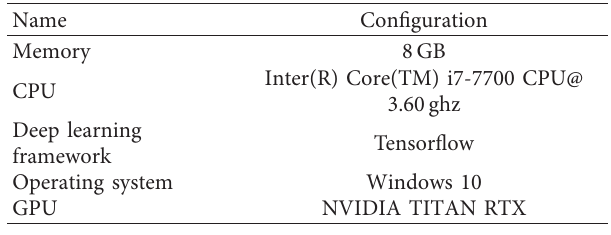
Figure 5: Flow chart of transfer learning. Table 1: Experimental environment.